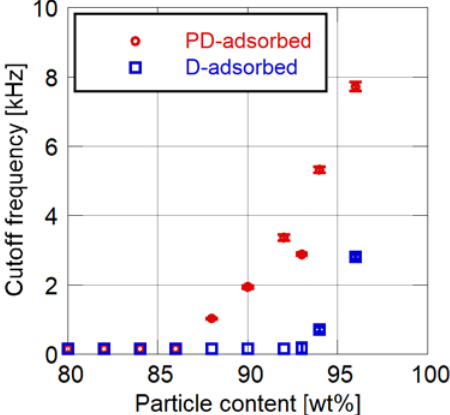
Figure 4. Cutoff frequency related to particle content.